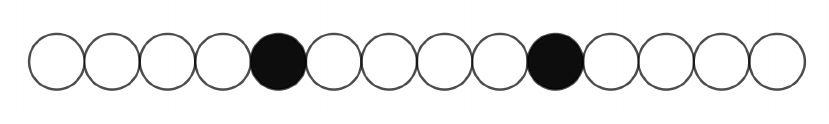
Figure 1 . The A 14 Dynkin diagram, with the resolved nodes in